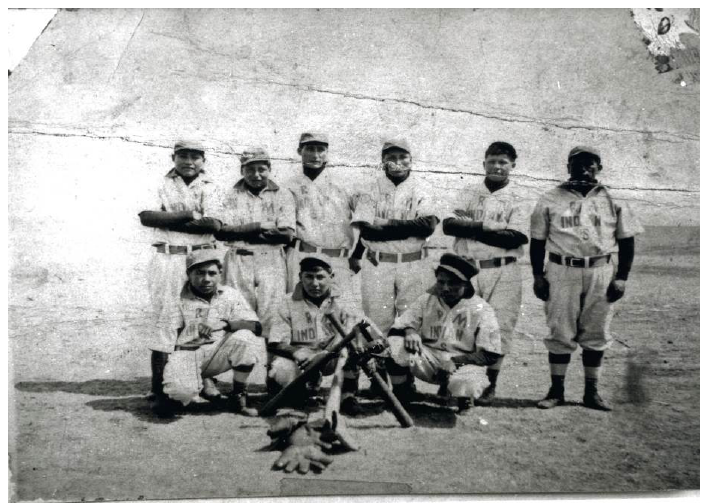
Figure 7. Rainy Mountain, Spring 1913 Ball Team. 1913. Unknown